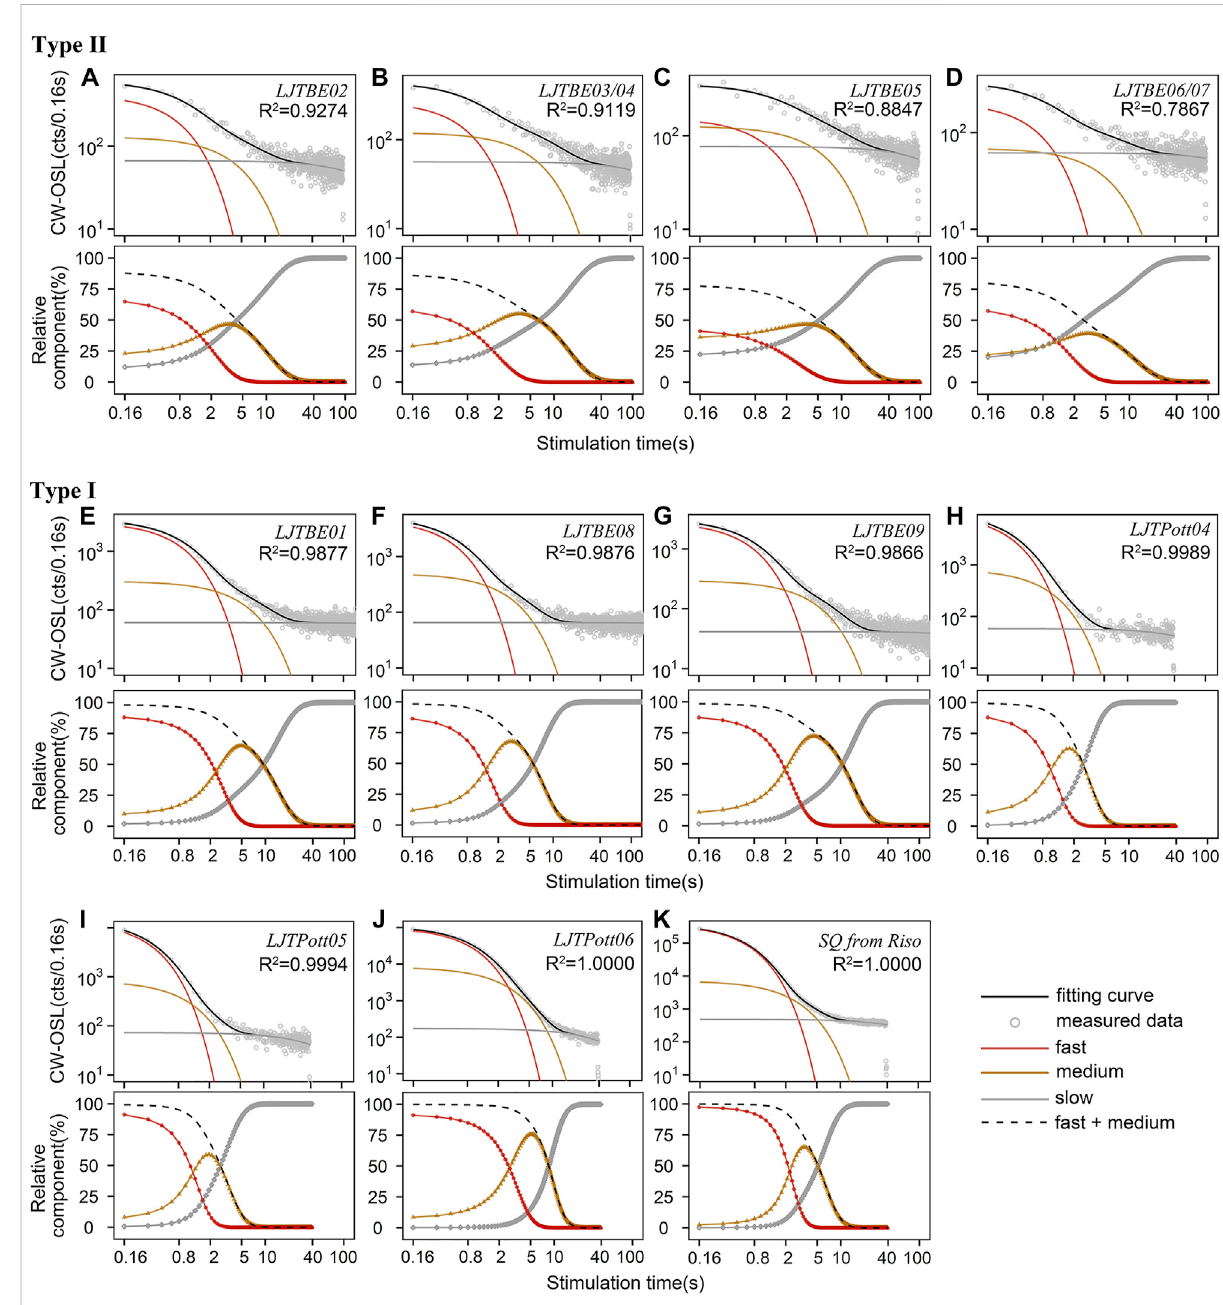
FIGURE 2 The componentphoton counts and relativepercentagesof thenaturalOSL decay curves after deconvolution using CW-OSL fi tting.All original curve data are obtained from the pure quartz OSL-SAR dating procedures. (A – D) Type II samples. This type of sample is dim, which shows the characteristicsofaslowdecayrate.IntheinitialOSLcurves(within0.8 s),arelativelyminorproportionoffastcomponents,orevennotdominatedby fast components, and signi fi cant medium and slow components. Four samples belong to type II, their preheat temperature is 260 ° C, and their excitation temperature is 180 ° C. (E – K) Type I samples. This type of sample is bright, showing a fast decay rate. The fast component dominates the initial OSL signal (within 0.8 s), while the medium and slow components account for a minor proportion. Six samples belong to type I, their preheat temperature is 200 ° C, and their stimulation temperature is 125 ° C. (K) Is a control sample of the standard radiation source calibration quartz (SQ) provided by